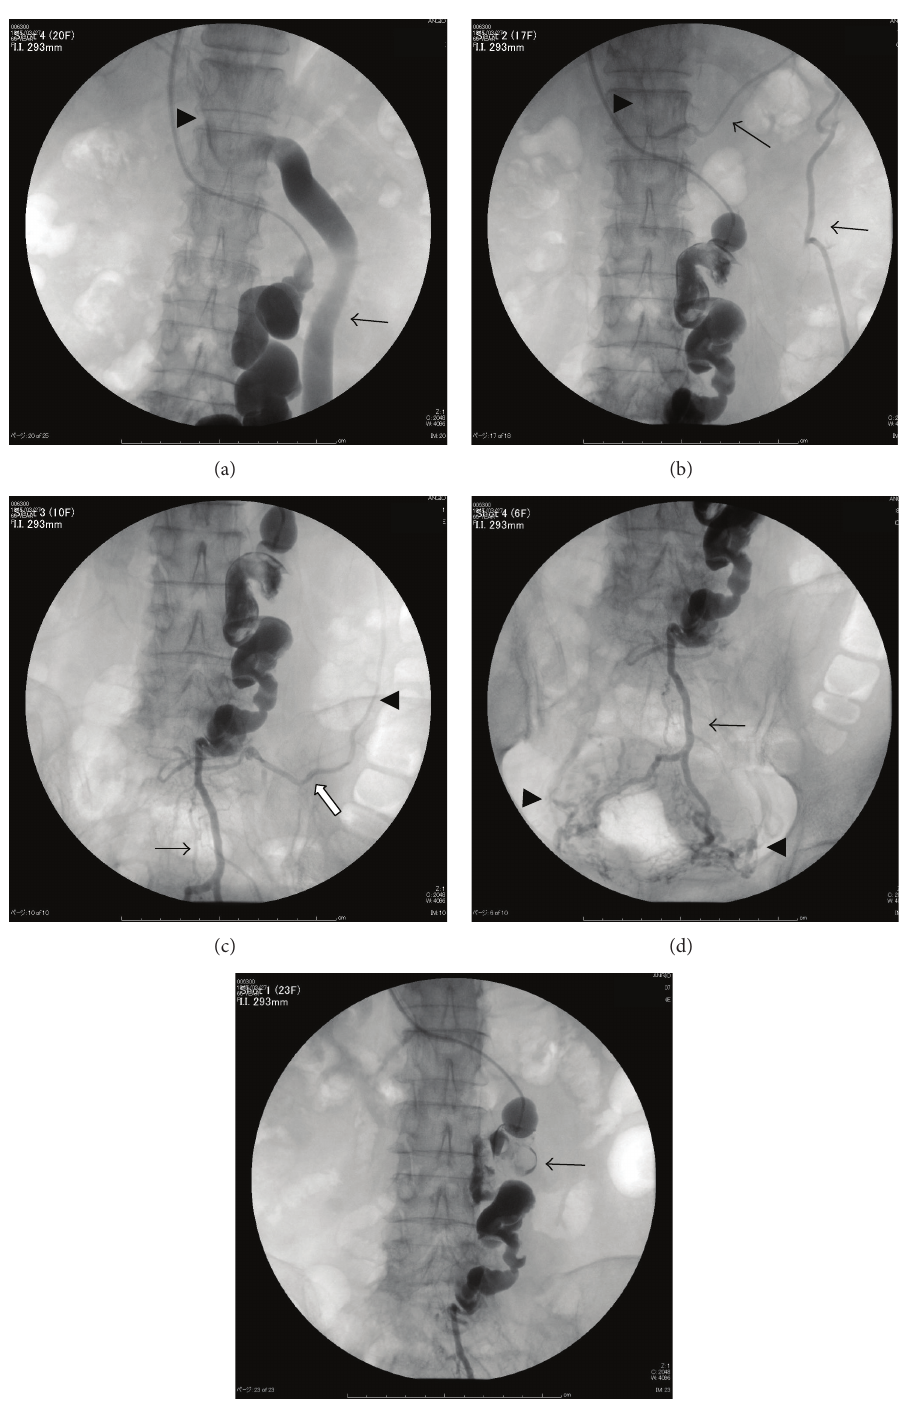
Figure 2: (a) Transjugular retrograde obliteration (TJO) on the 1st day: retrograde shunt venogram shows left ovarian vein and dilated inferior mesenteric vein (arrow) and portal vein (arrowhead). (b) Retrograde shunt venogram on the 2nd day shows marginal vein (arrow) communicated with portal vein (arrowhead). (c) Retrograde shunt venogram on the 2nd day shows superior rectal (arrow), sigmoid (white arrow), and marginal veins (arrowhead). (d) Retrograde shunt venogram on the 2nd day shows superior rectal vein (arrow) communicated with bilateral internal iliac veins (arrowhead). (e) Retrograde shunt venogram on the 3rd day shows thrombus formation (arrowhead) in the mesocaval shunt. The marginal vein communicated with portal vein was not